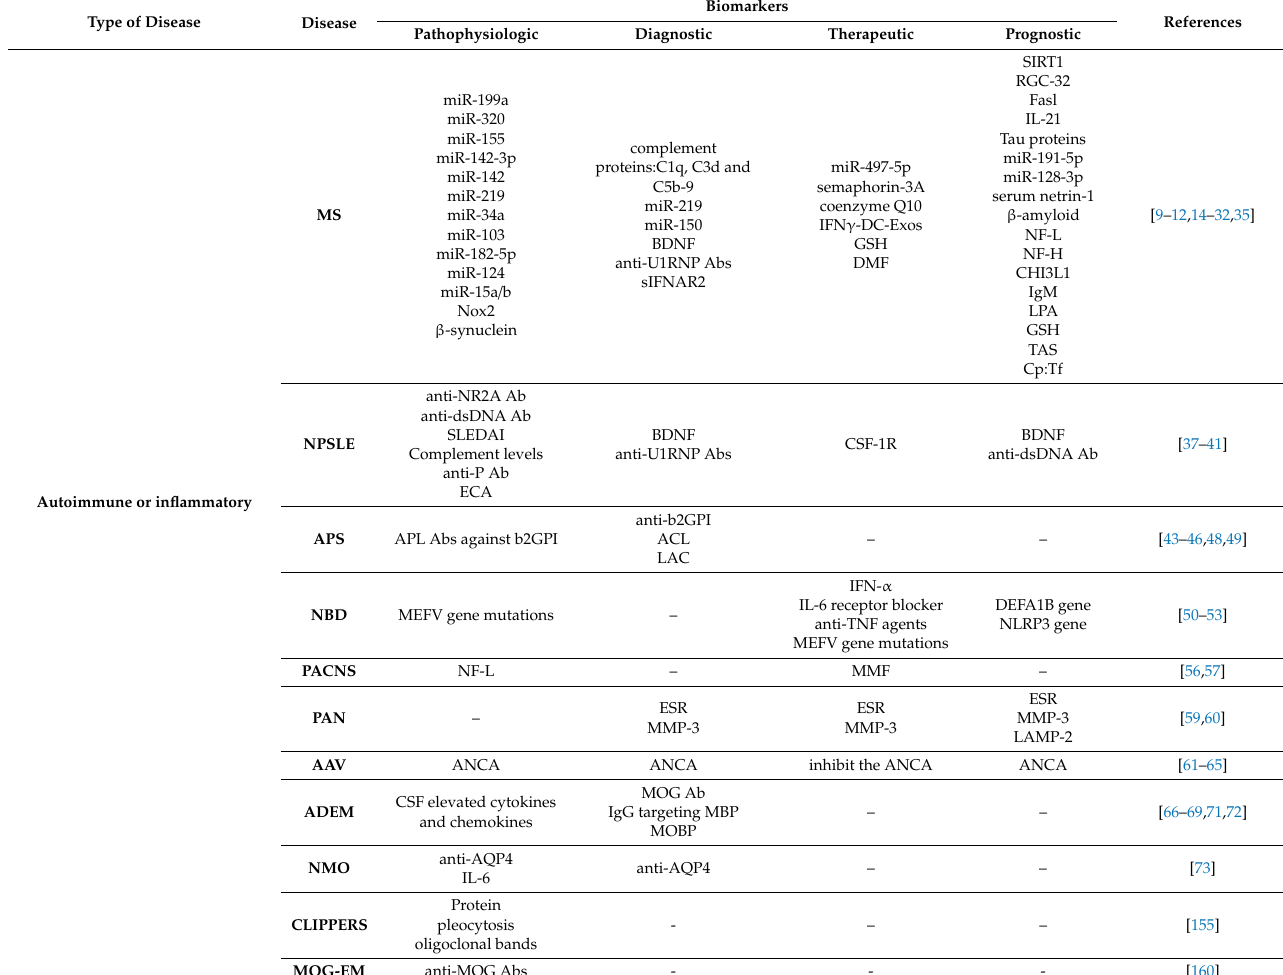
Table 1. Summary of molecular biomarkers in multiple sclerosis and its related disorders (abbreviations are below